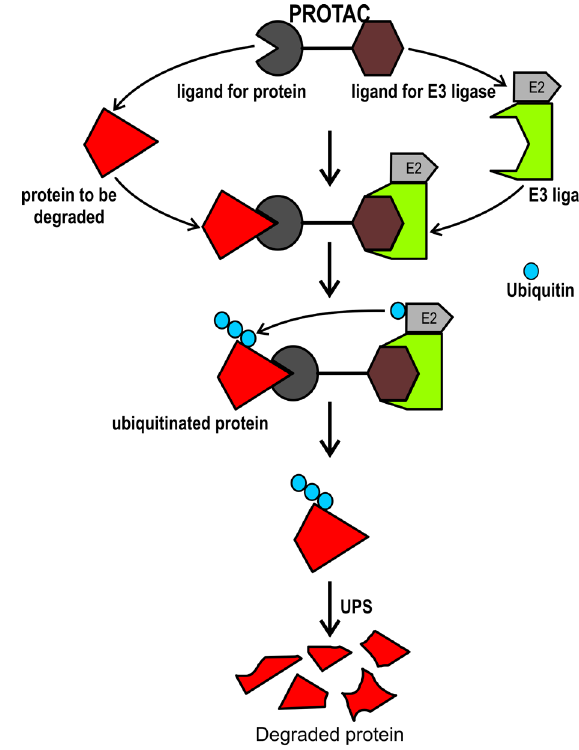
Figure 1. PROTACs. Representation of molecular mechanism that is used by Table 2. Some E3-ligases used for PROTACs